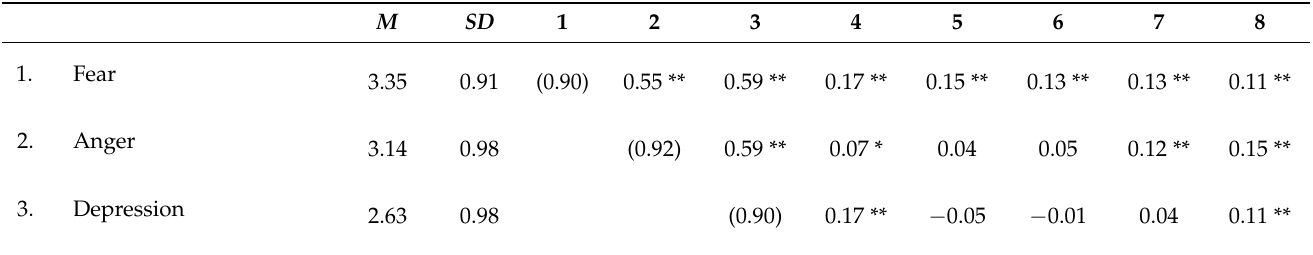
Table 2. Descriptive statistics of the key variables ( n =